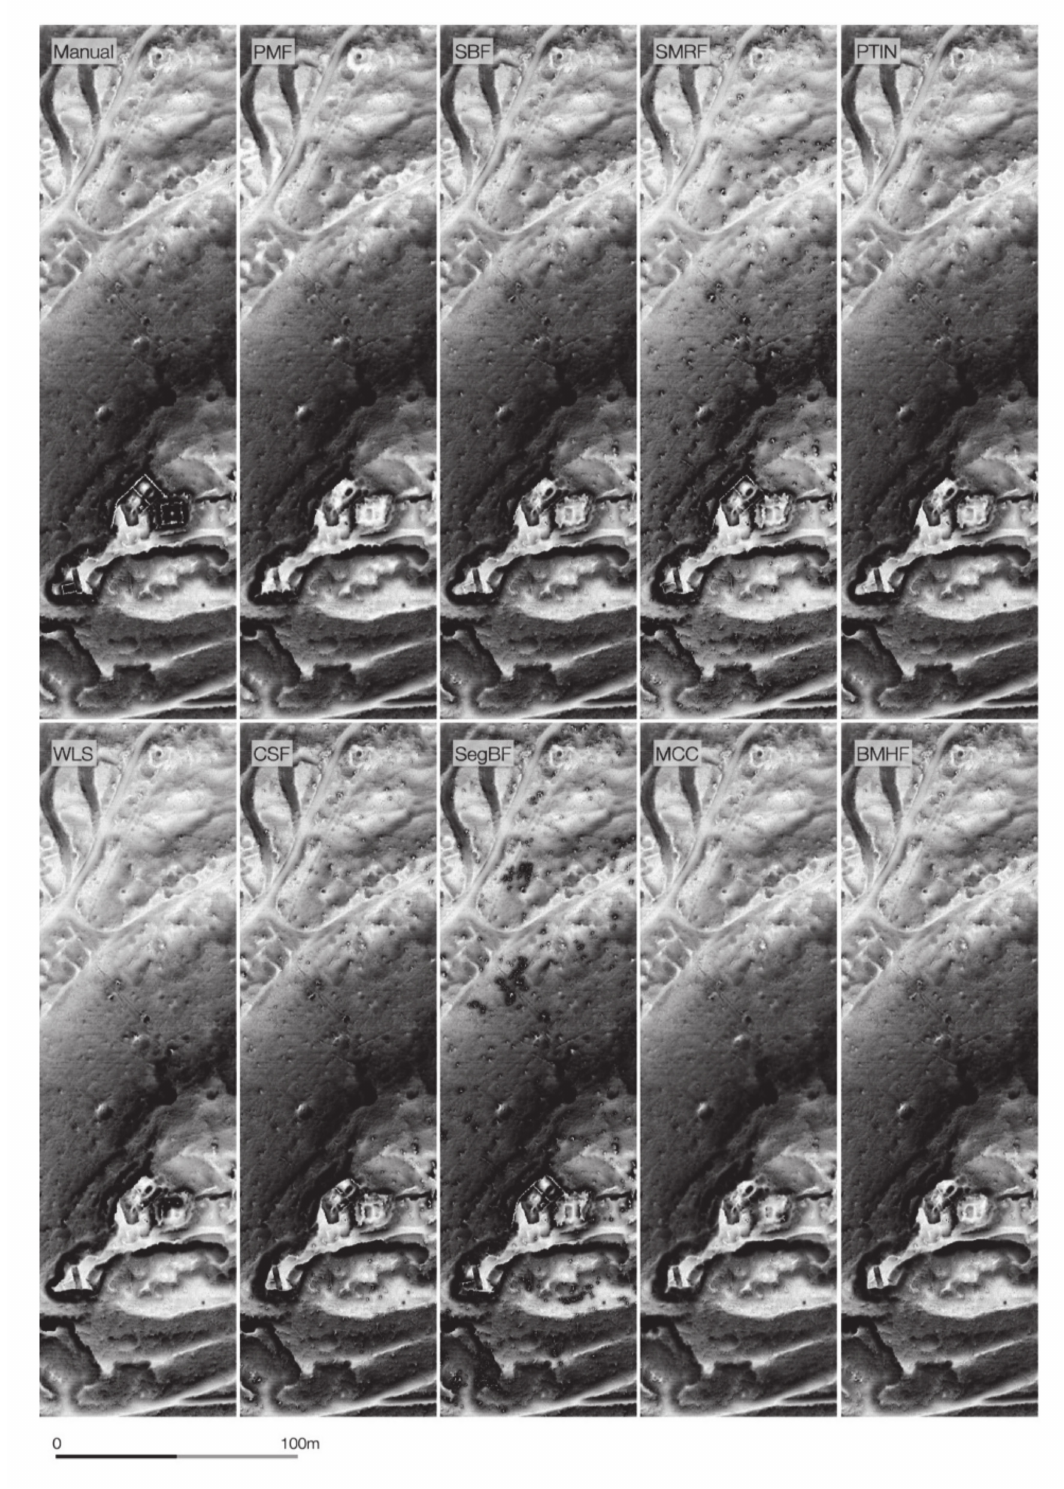
Figure 4. Test site AT, comparison of different filters for ground point classification. DFM processing: filter as stated in the caption, cell size 0.25 m; other processing according to Table 3. (After [20]: Figure 2, published under CC-BY